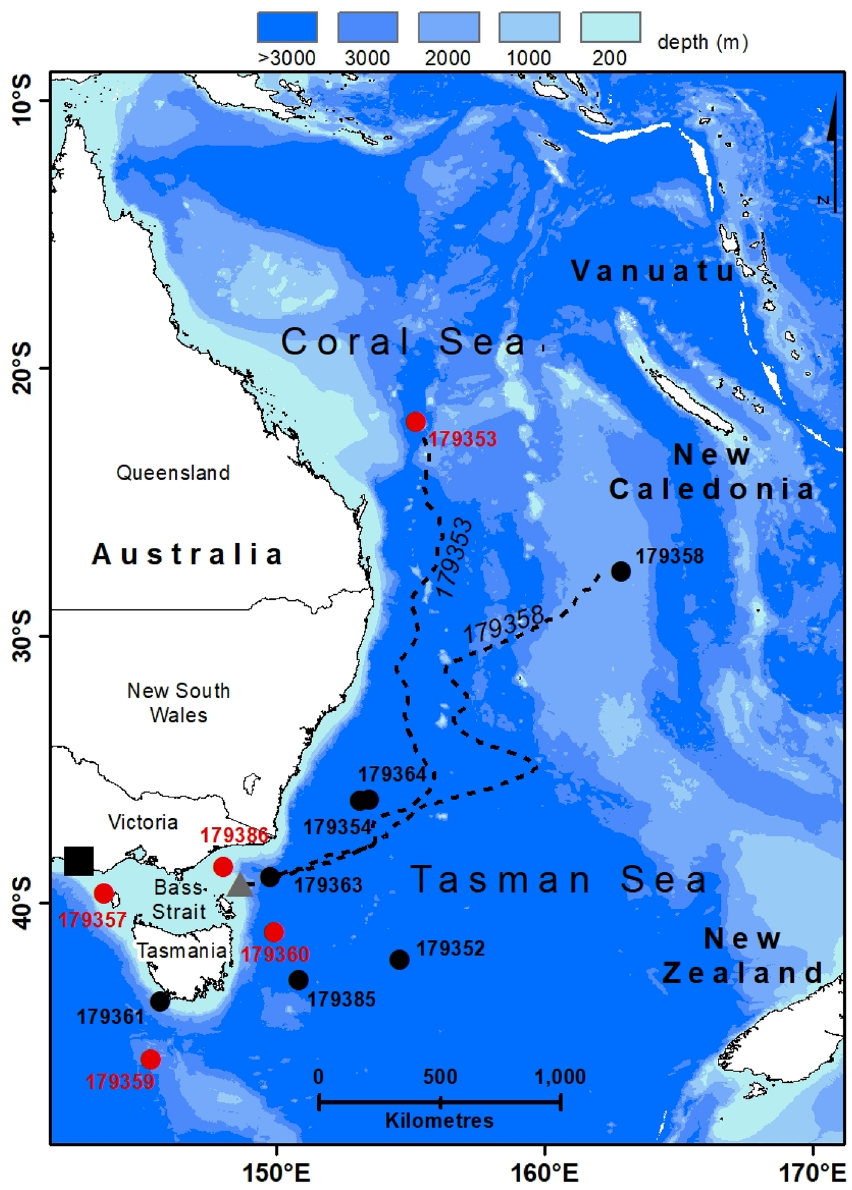
Figure 1. Map showing location of the study area. Black square denotes tagging location. Grey triangle denotes approximate exit point from Bass Strait for eels leaving towards the east. Black circles denote end positions of tags with premature ending and sudden rise to the surface. Red circles denote end positions where eels were inferred to be predated. The dashed black lines shows the approximate trajectories of eel 179353 and eel 179358. Figure produced using ESRI ArcGIS 10.7.1 (https:// www. esri. com/ en- us/ arcgis/ produ cts/ arcgis- deskt op/ overv